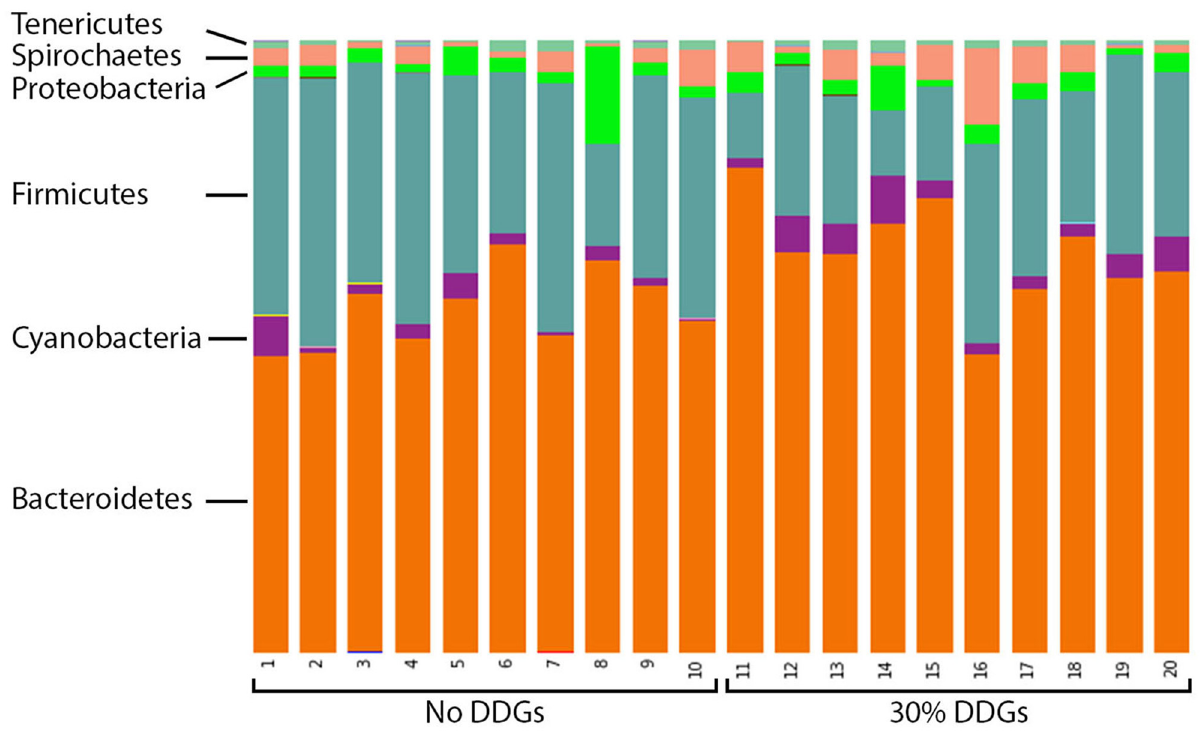
Fig 3. Feeding increased insoluble fiber was associated with shifts in the relative abundance of major phyla in microbiota samples. Stacked bar charts representing proportional abundance of major phyla in the colonic microbiota of twenty 9-week-old pigs fed either no DDGS or 30% DDGS for 5 weeks. Firmicutes:Bacteroidetes ratios were significantly lower in pigs fed 30% DDGS ( P =